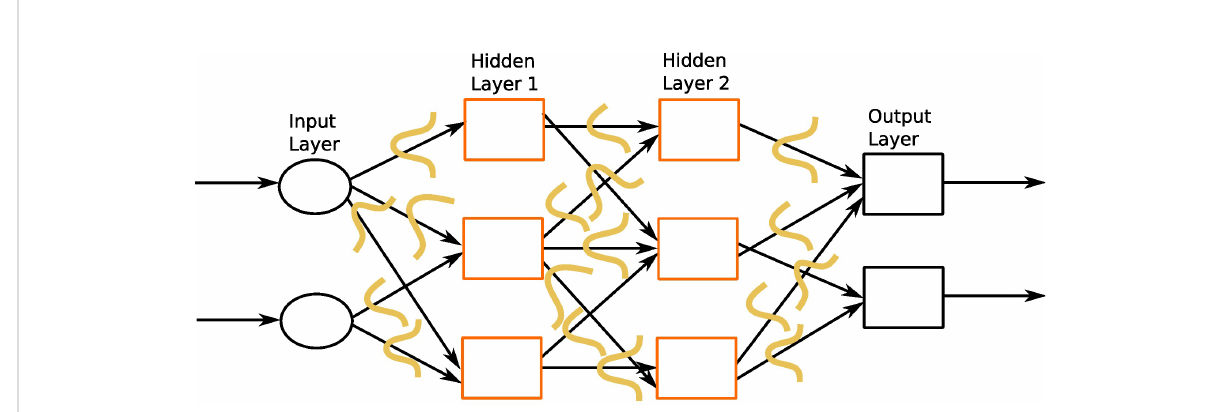
FIGURE 8 An instance of Bayesian regularized neural network with one input layer, two intermediate hidden layers, and one output layer. The orange curves represent prior distribution on each weight